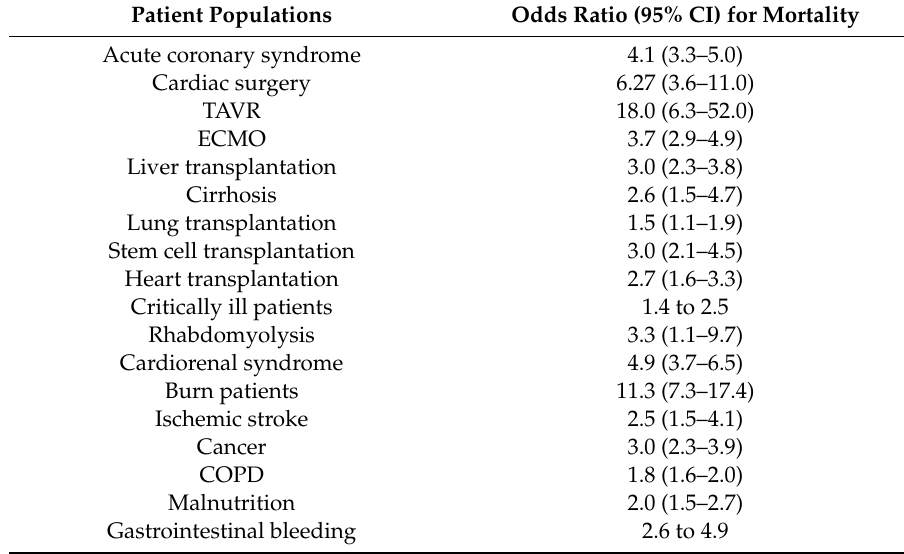
Table 6. Mortality outcomes of acute kidney injury in di ff erent patients’ population from selected studies